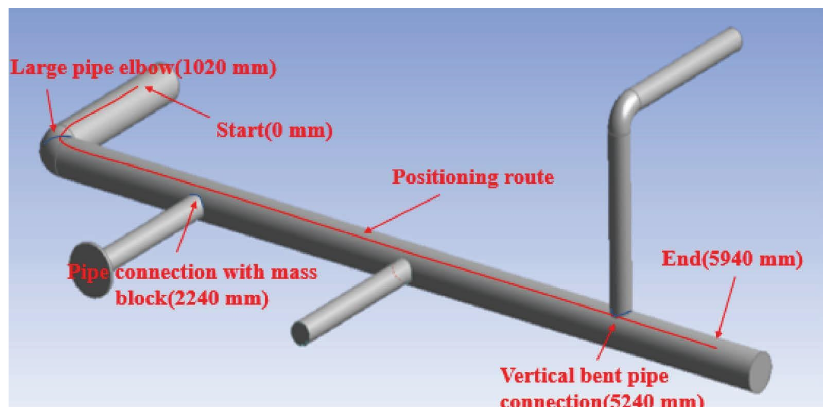
Figure 7: Schematic diagram of crack locations.